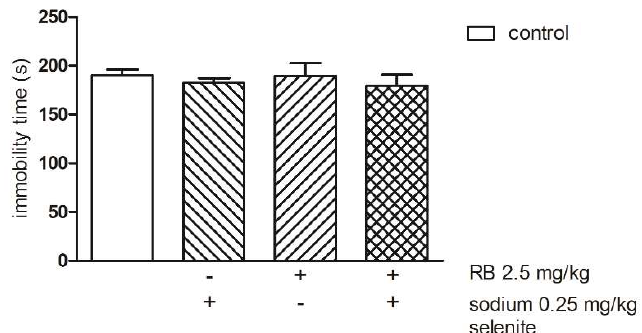
Figure 4. The effects of combined administration of Se and reboxetine (RB) on the total duration of immobility in the FST in mice. The values represent the mean ± SEM. Sodium selenite was injected IP 30 min before the test.